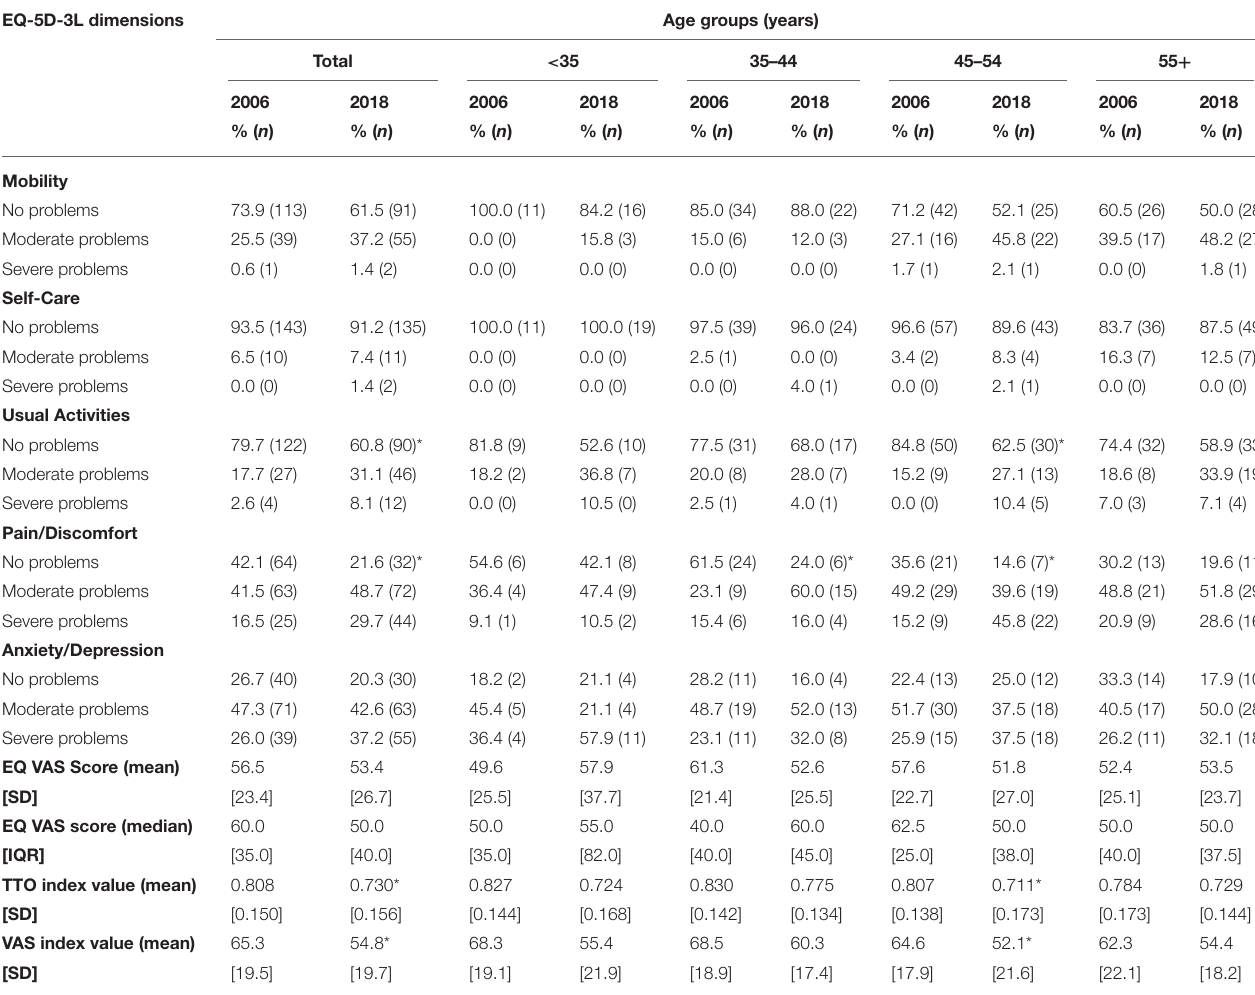
TABLE 2 | Problems in EQ-5D-3L dimensions (%, n ), mean and median EQ VAS score, mean TTO index value, mean VAS index value, by age group, homeless people in 2006 and 2018,